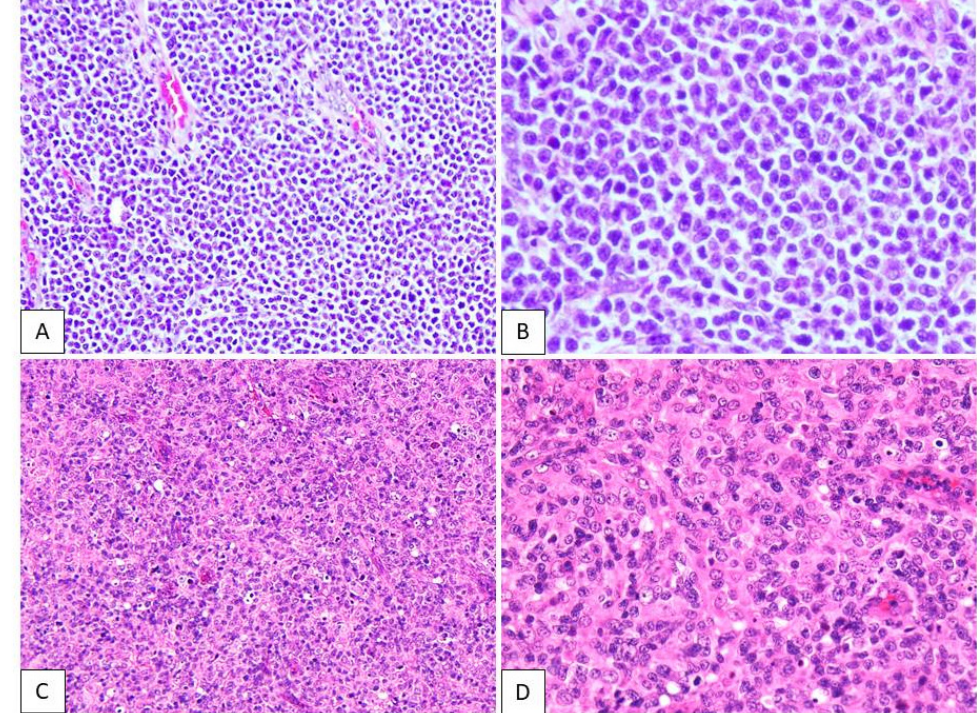
Figure 2. Hematoxylin and eosin staining in adult T-cell leukemia/lymphoma (ATLL) and peripheral T-cell lymphoma, not otherwise specified (PTCL-NOS). The neoplastic lymphoid cells in ATLL are typically medium to large, and the nuclear chromatin is coarsely clumped with distinct ( A , B ). The neoplastic lymphoid cells in PTCL-NOS are numerous medium-sized and/or large cells with irregular, pleomorphic, hyperchromatic, or prominent nuclei ( C , D ). Table 1. SOX4 and p16 immunohistochemical staining and scores of patients with adult T-cell leukemia/lymphoma (ATLL) and peripheral T-cell lymphoma, not otherwise specified